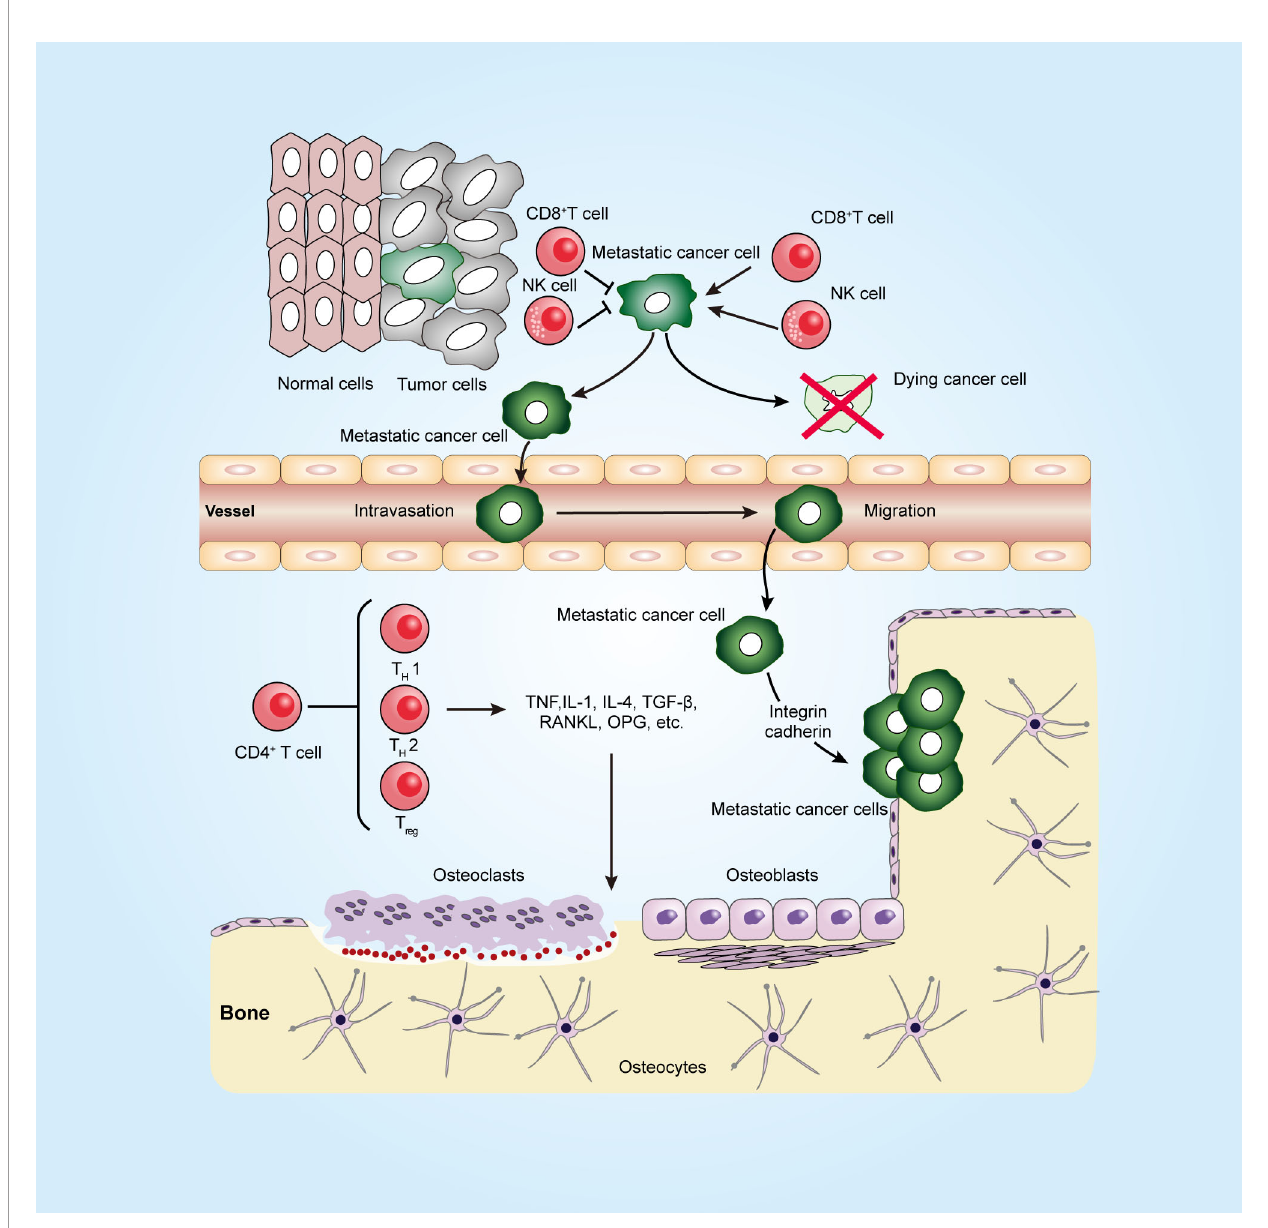
FIGURE 1 | Immune system in a long journey to develop bone metastasis. To establish the metastatic tumor, cancer cells escape from the tumoricidal immune response that is mediated by killer cells, such as CD8+ T cells and natural killer (NK) cells, and then invade through the surrounding stroma and intrude into blood vessels (intravasation). At the metastatic site, the arrested tumor cells in microvessels escape from the blood vessel (extravasation). Metastatic tumor cells can interact with both osteoclasts and osteoblasts in the bone microenvironment and release factors, such as TNF, TGF- b , and RANKL, to promote osteoclastogenesis and osteoblastogenesis. CD4+ T cells can produce not only osteoclastogenic cytokines such as IL17 and TNF but also anti-osteoclastogenic cytokines such as IFN g and IL4. The fi gure was designed using Adobe Illustrator